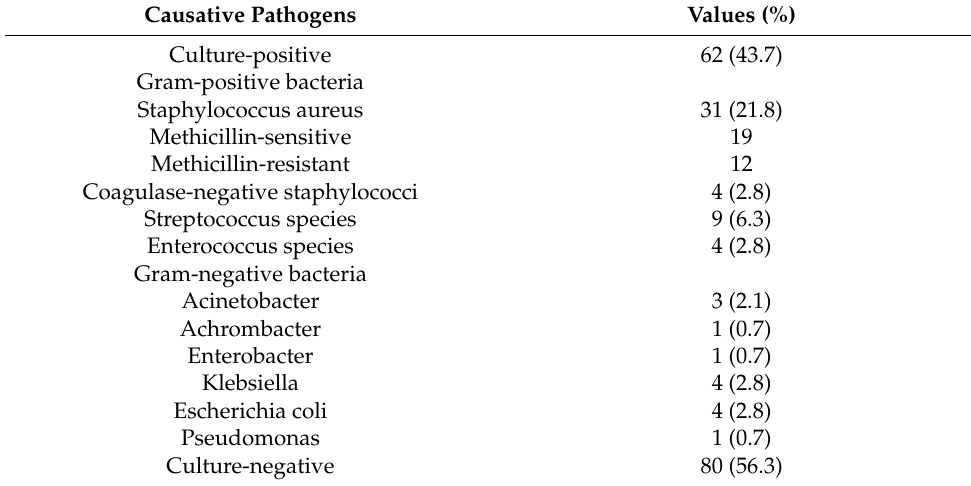
Table 2. Microbiologic